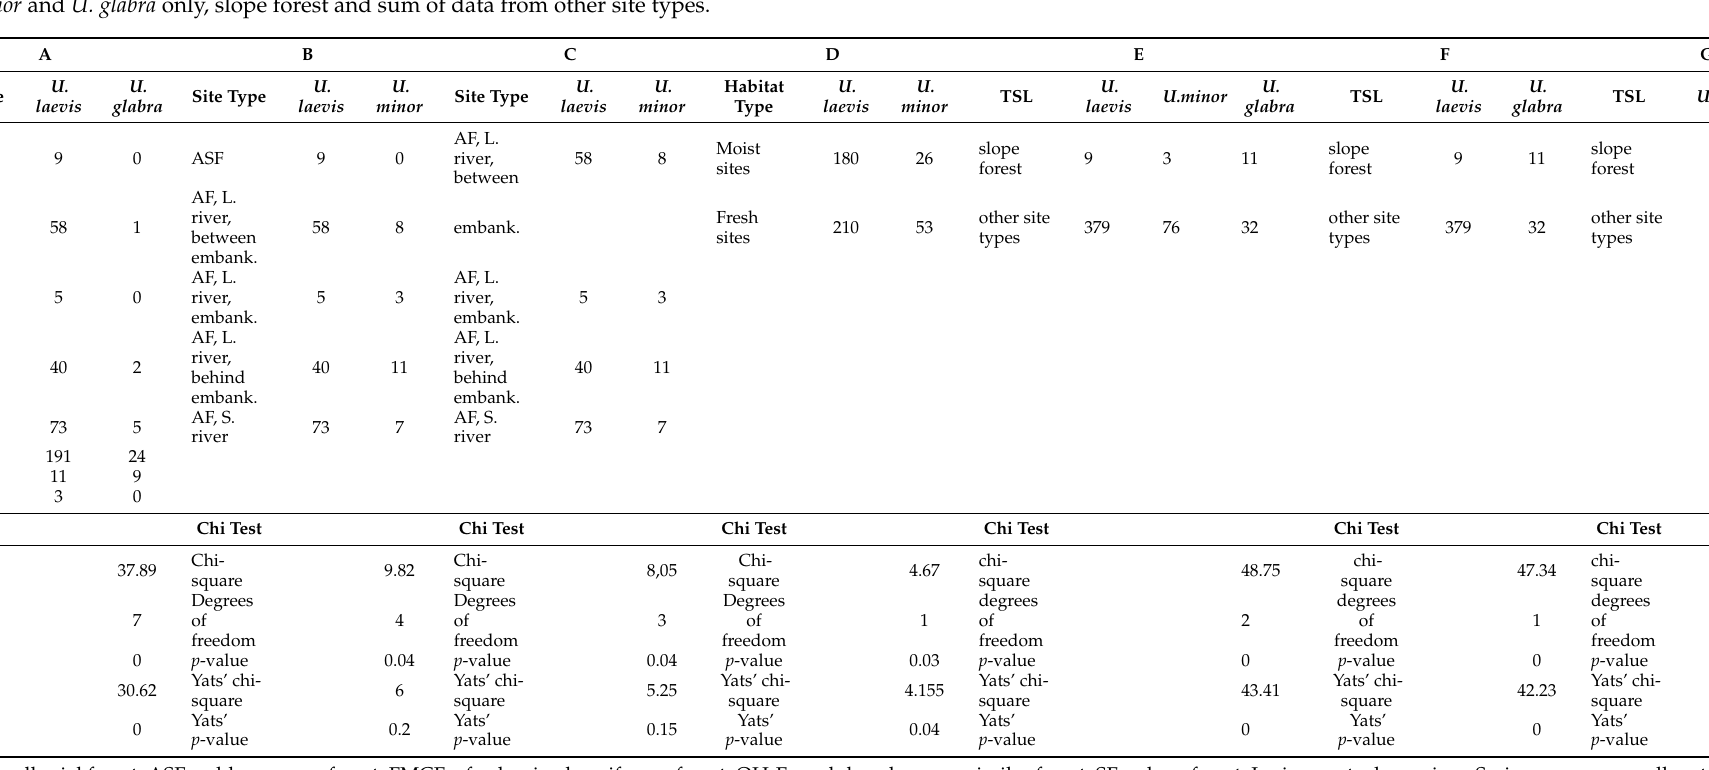
Table 5. Distributions of partial data from Table 4, which also differ statistically significantly. A—localities of U. laevis and U. glabra only; B—localities of U. laevis and U. minor and from moist sites only; C—localities of U. laevis and U. minor and from alluvial sites only; D—localities of U. laevis and U. minor only, sums of moist and fresh sites; E—localities of U. laevis U. minor and U. glabra, slope forest and sum of data from other site types; F—localities of U. laevis and U. glabra only, slope forest and sum of data from other site types; G—localities of U. minor and U. glabra only, slope forest and sum of data from other site